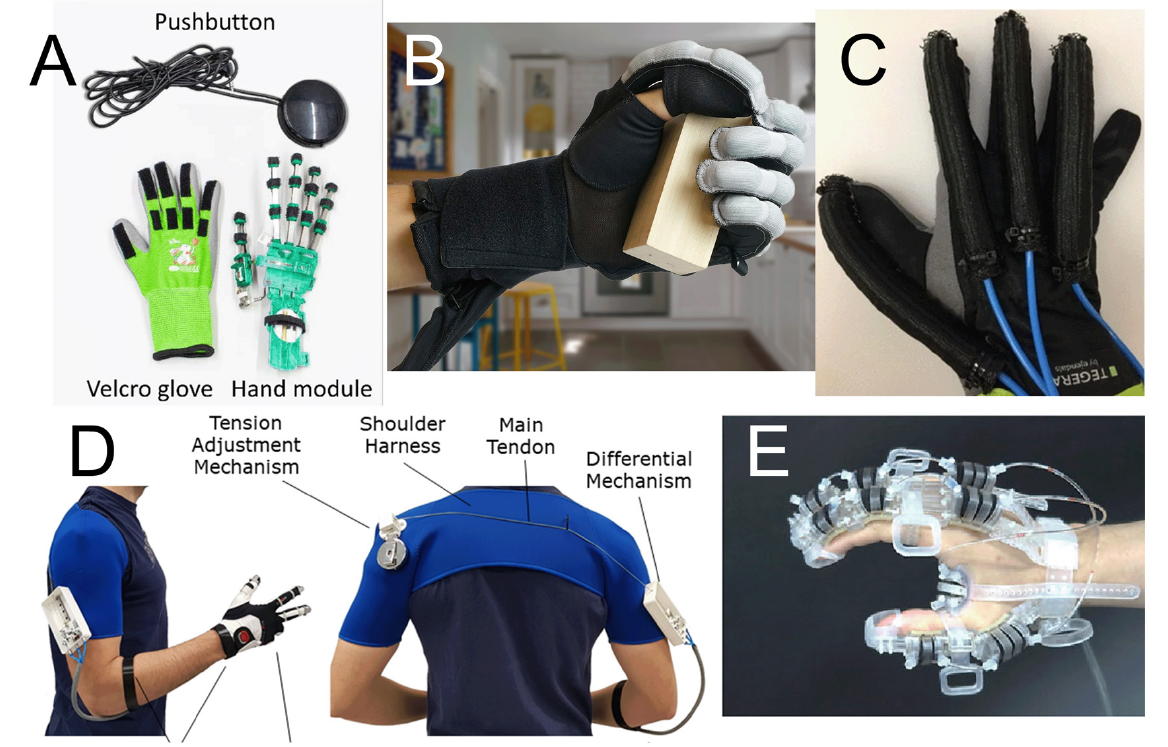
Figure 3. ( A ) PEXO [35], ( B ) Harvard–Cambridge soft robotic glove [38], ( C ) University of Basrah soft robotic glove [38], ( D ) OPEN BIONICS [41], and ( E ) assistive exoskeleton hand glove (Exo-Glove PM) [43].